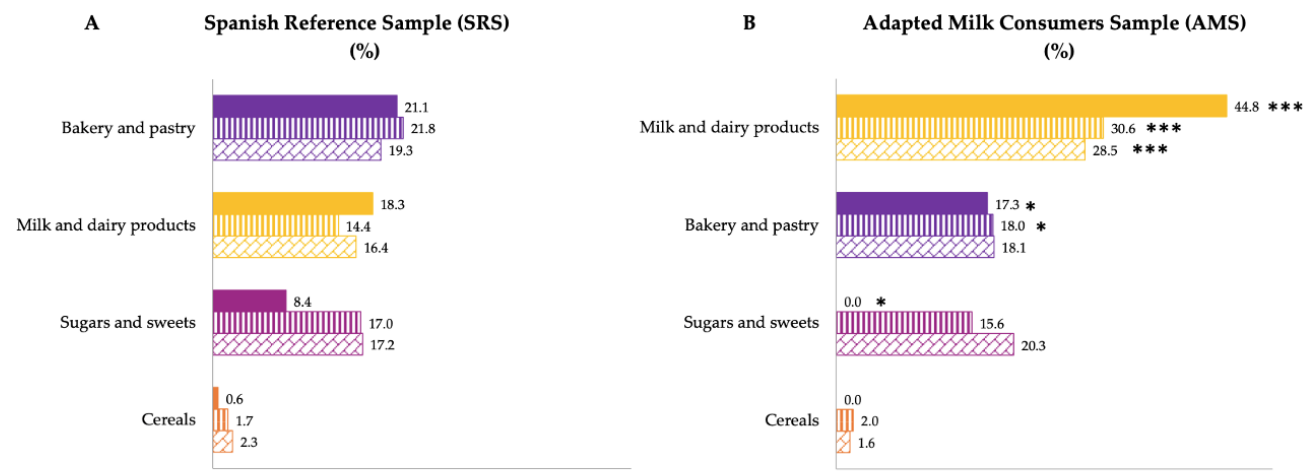
Figure 4. Dietary food and beverage groups contributing to added sugar intakes (%) from the EsNuPI study population (“Spanish Pediatric Population”) in both the Spanish Reference Sample ( A ) and the Adapted Milk Consumers Sample ( B ) by age-group. * p ≤ 0.05 compared to reference sample (Mann–Whitney test); *** p ≤ 0.001 compared to reference sample (Mann–Whitney test). Only foods contributing ≥ 1% to total added sugar intakes of the population have been